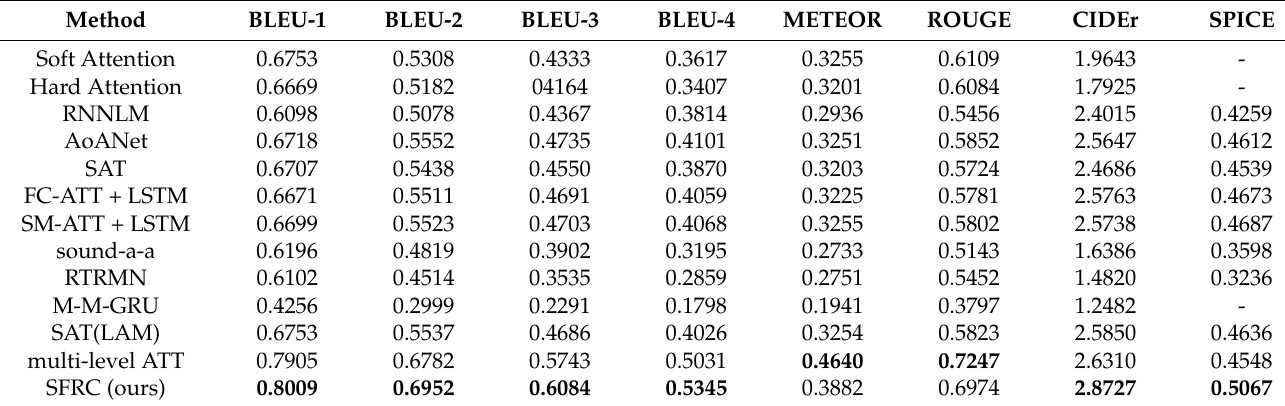
Table 3. Quantitative comparison results on RSICD